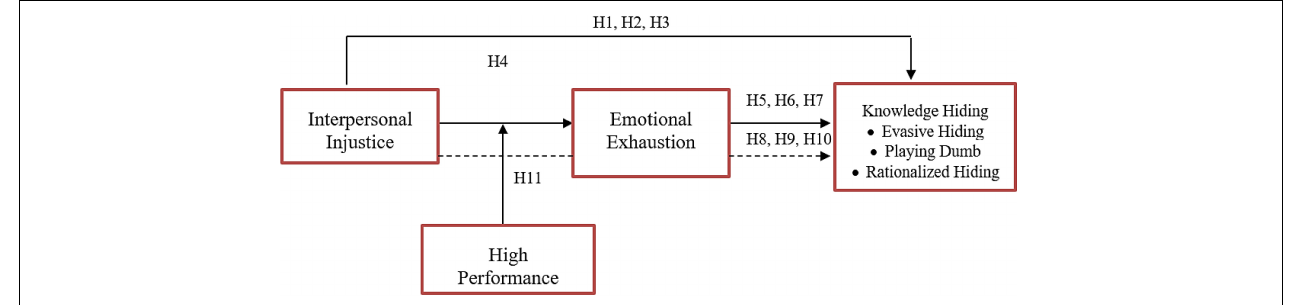
FIGURE 1 | Theoretical framework. INJ, interpersonal justice; EE, emotional exhaustion; EH, evasive hiding; PD, playing dumb; RH, rationalized hiding; WS, high-performance work